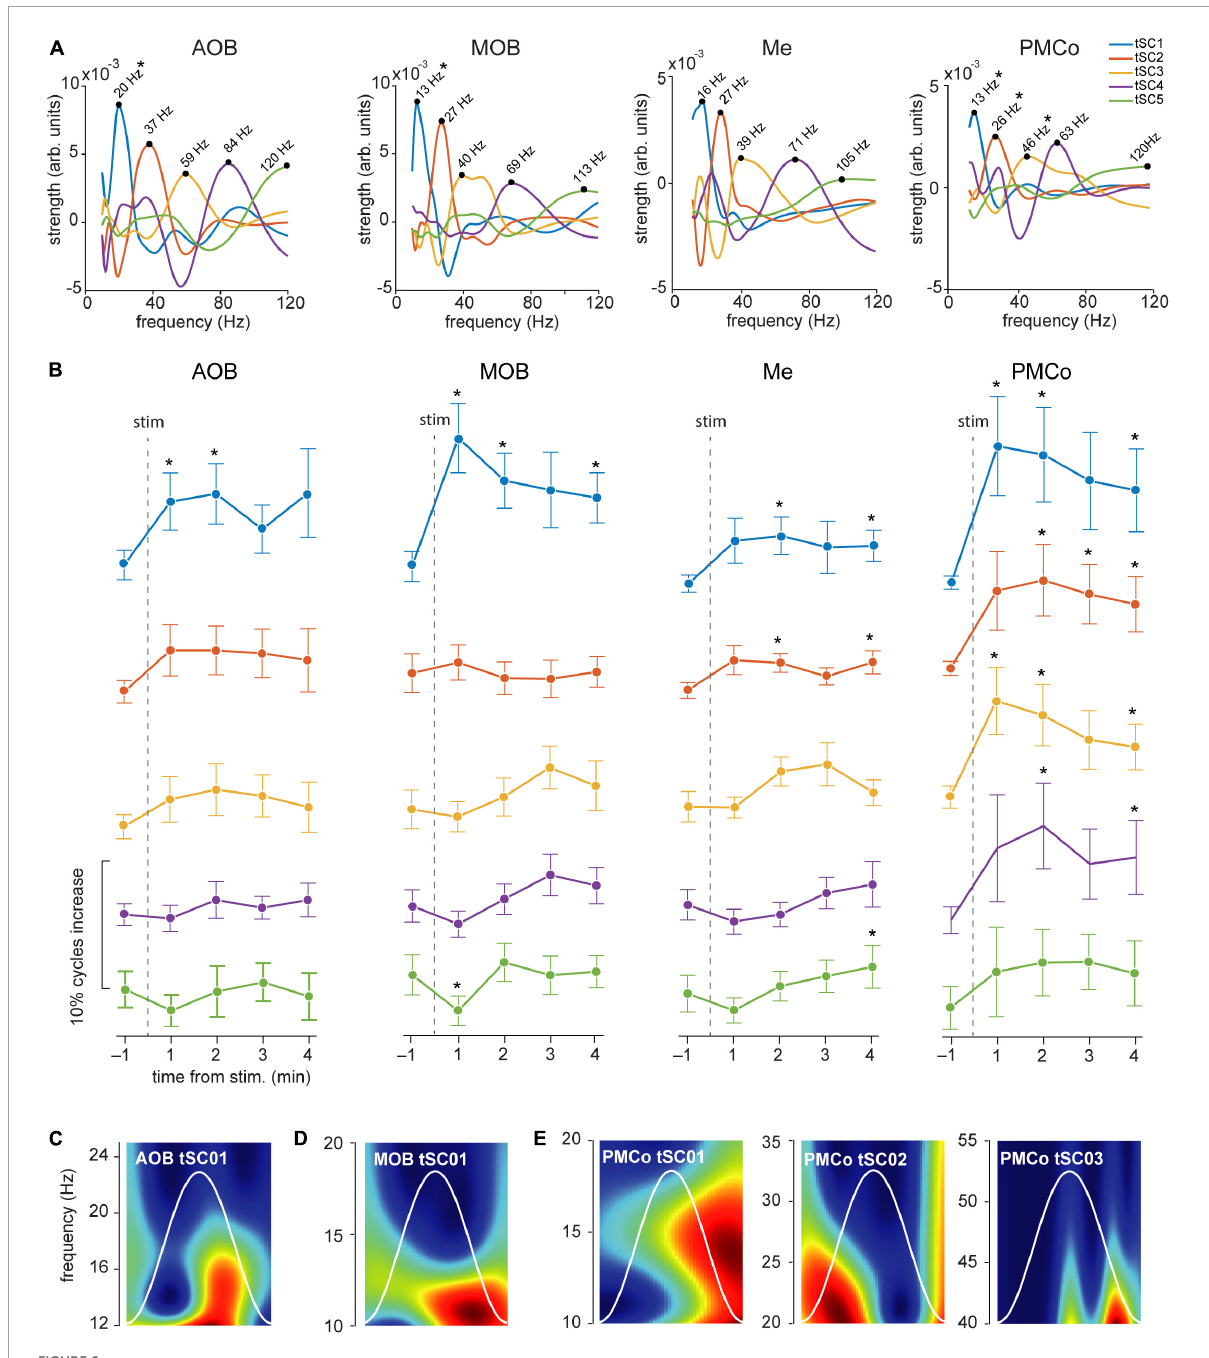
FIGURE6 Temporal analysis of the theta cycles and evoked tSCs for neutral stimuli. (A) Spectral signatures in the frequency domain of the analyzed tSCs, for the four brain regions, during the exploration of neutral stimuli. Asterisks indicate those tSCs that showed a significant increase from the control period. (B) Proportion of theta cycles with nested components per minute of the five tSC, before and after the neutral stimuli presentation * p < 0.05 compared to pre-stimulus value. (C) Representative wavelet spectrogram of tSC1 in AOB; (D) tSC1 in MOB; (E) tSC1, tSC2, and tSC3 in